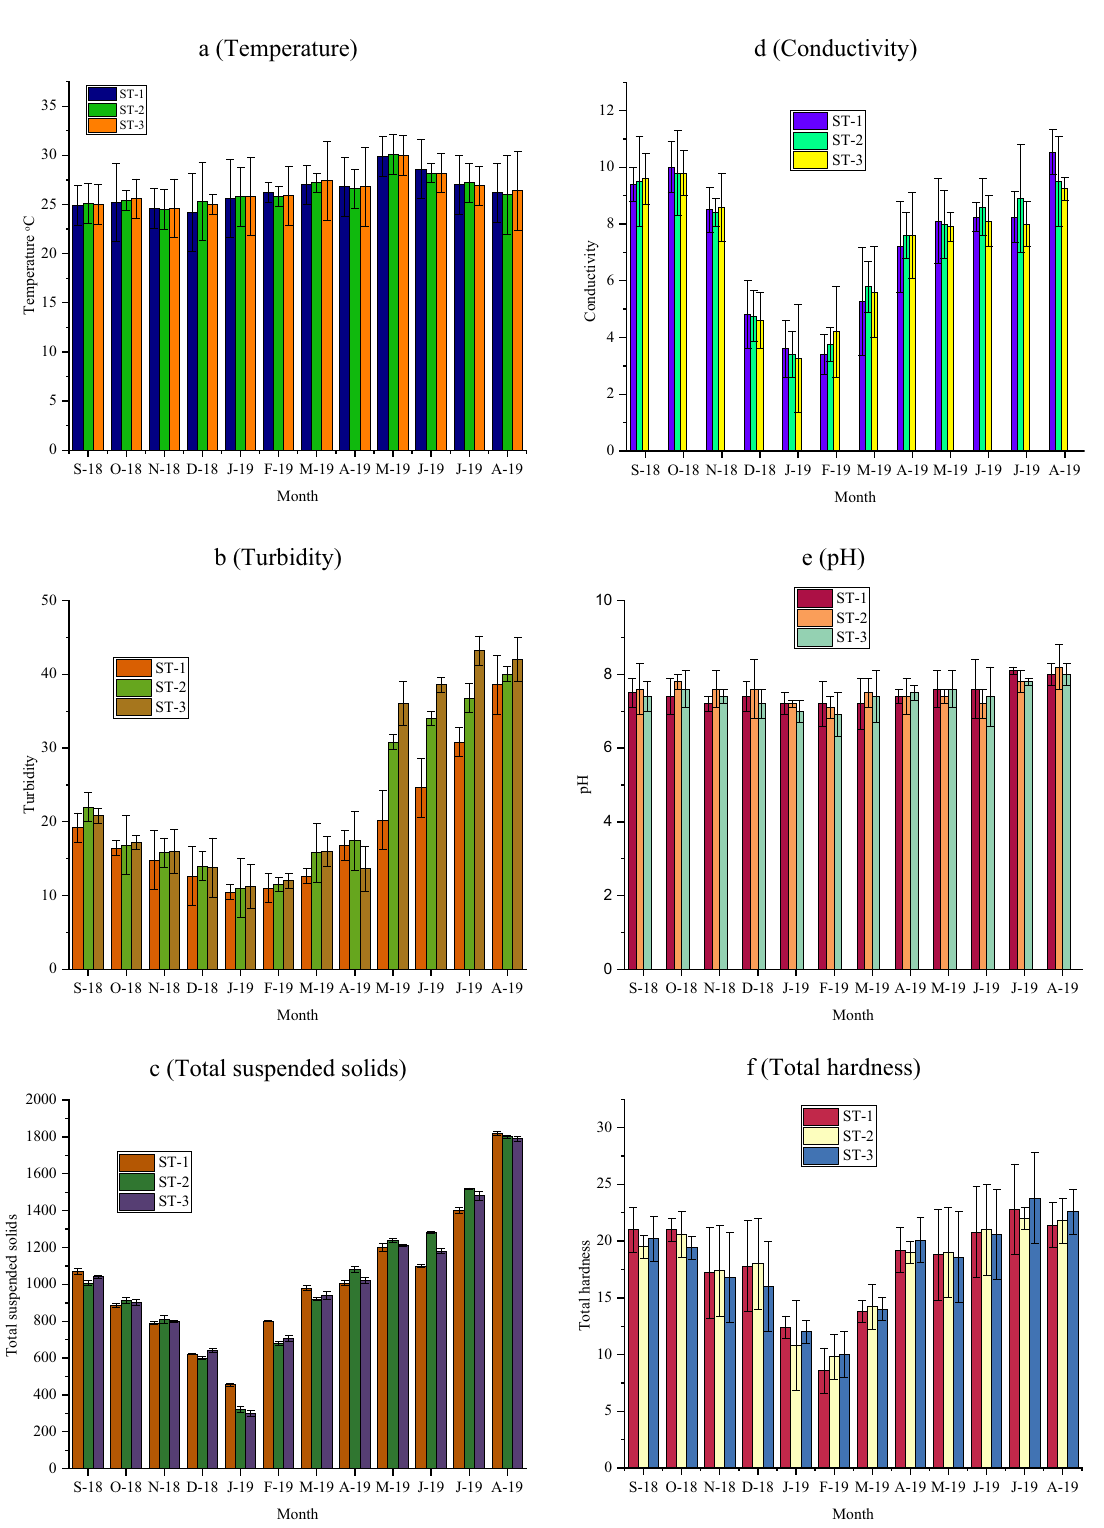
Fig. 2 Seasonal variations of physicochemical parameters in Perumal Lake during September 2018 to August 2019 (Temperature, Turbidity, Total Suspended Solids, Conductivity, pH and Total